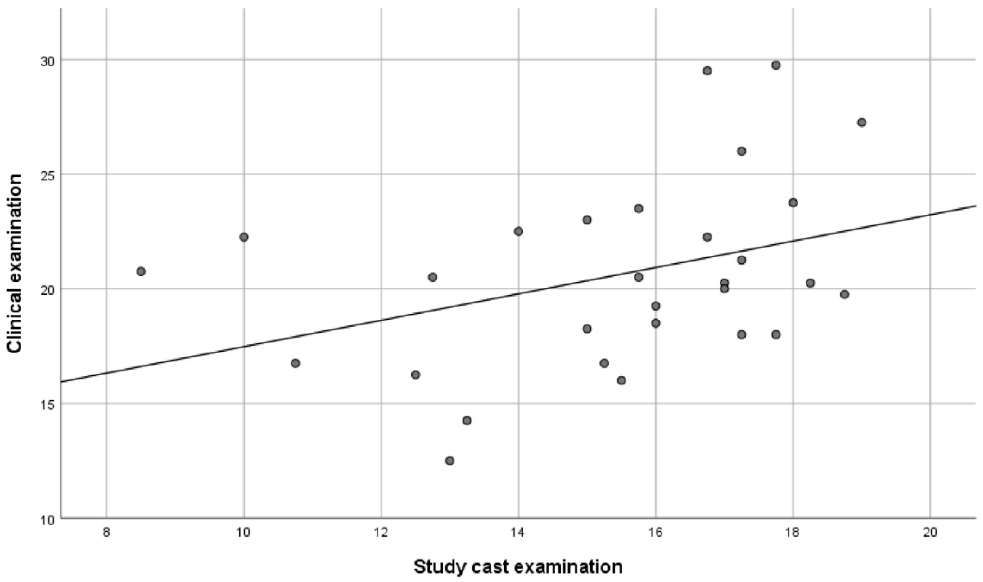
Figure 4. Scatterplot explaining the relationship between the total amount of occlusal contacts in the study cast examina- tion and the total occlusal contact area in mm 2 in the digital examination ( n = 29). Every dot represents one of the included participants ( p < 0.05).